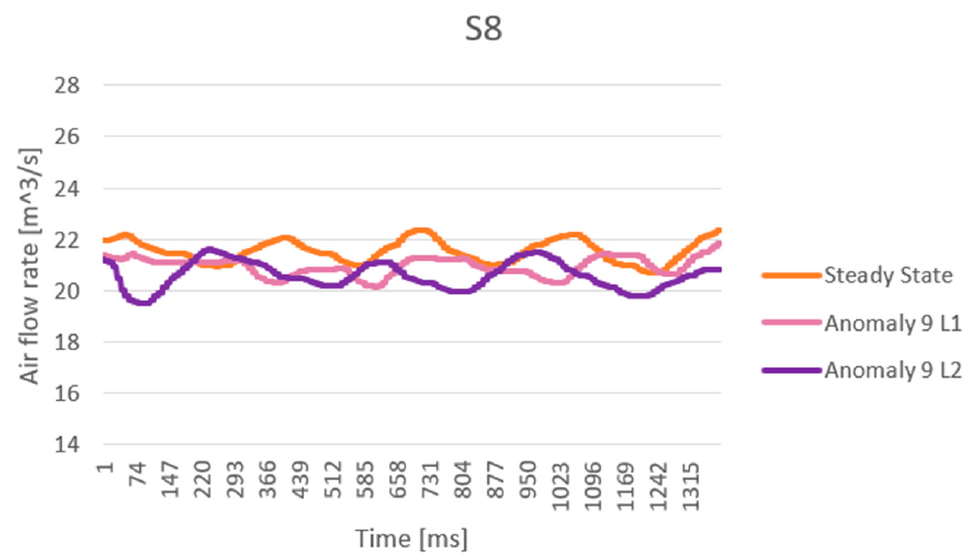
Figure 18. Outlet air flow rate of steady state, anomaly 9 level 1 and 2 samples.